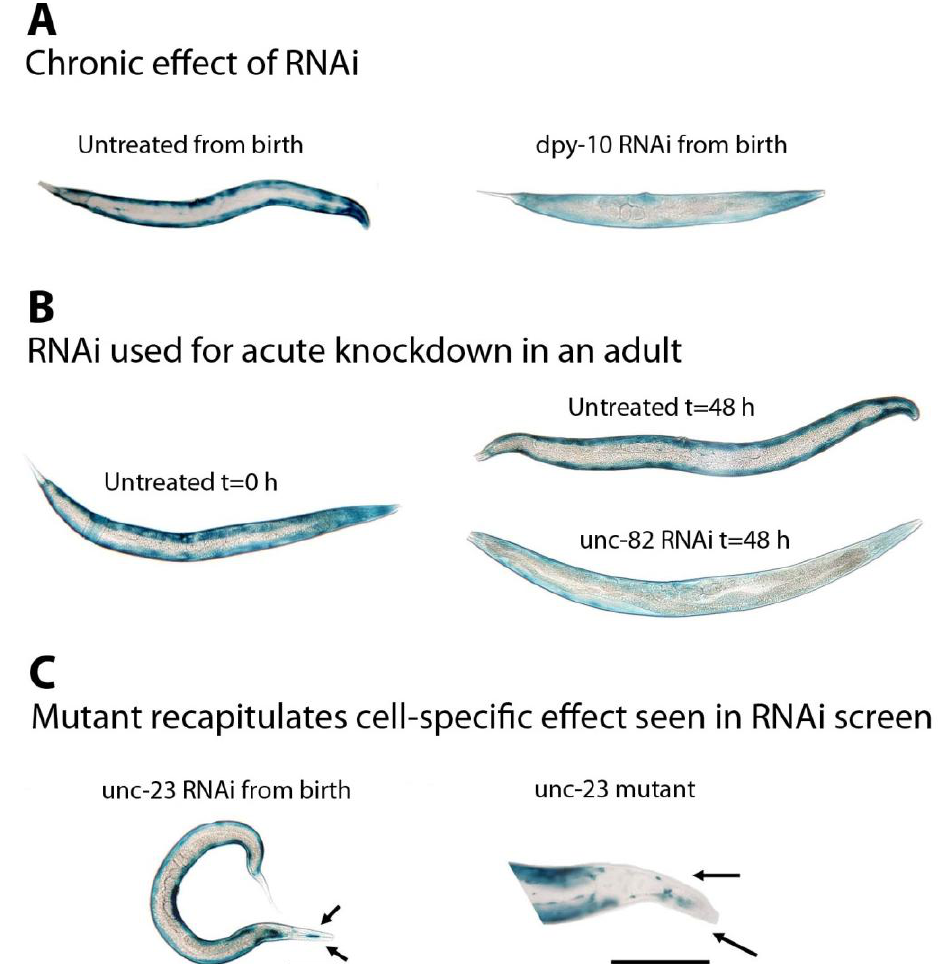
Figure 2. Examples of use of RNAi to identify genes regulating muscle protein degradation. (A) Chronic feeding of RNAi (Figure 1A) can be used to confirm that the RNAi feeding vector is working to produce the expected mutant phenotype, Dumpy (Dpy), and identify genes that when knocked down display less (cid:533) -galactosidase reporter protein activity (blue) in muscle. (B) Feeding RNAi to fully developed adult animals (Figure 1B) can be used to determine if a gene product is normally required to prevent protein degradation in muscle. In this instance, UNC-82 prevents (cid:533) -galactosidase degradation in all body-wall muscles. (C) Mutants can be used to confirm results from RNAi screens. These animals lack blue stain only in the head. (cid:36)(cid:79)(cid:79)(cid:3) (cid:71)(cid:68)(cid:87)(cid:68)(cid:3) (cid:68)(cid:85)(cid:72)(cid:3) (cid:87)(cid:68)(cid:78)(cid:72)(cid:81)(cid:3) (cid:73)(cid:85)(cid:82)(cid:80)(cid:3) (cid:87)(cid:75)(cid:72)(cid:3) (cid:179)(cid:80)(cid:88)(cid:86)(cid:70)(cid:79)(cid:72)(cid:3) (cid:80)(cid:88)(cid:87)(cid:68)(cid:81)(cid:87)(cid:180)(cid:3) screen [30], images are all to the same scale with the exception of the mutant in (C); both scale bars are 100